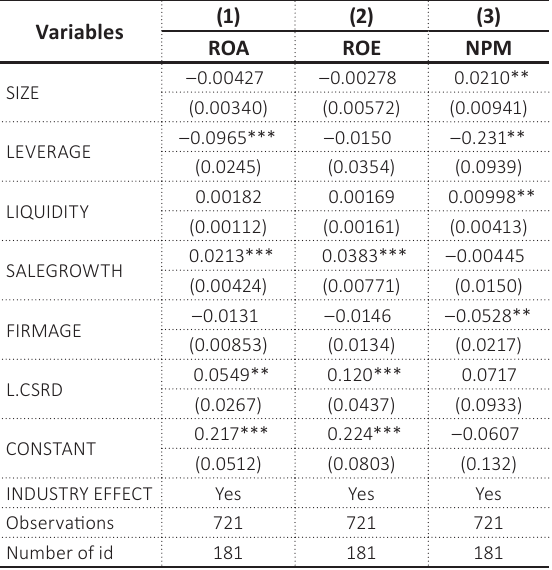
Table 7. Regression results of equation (2)